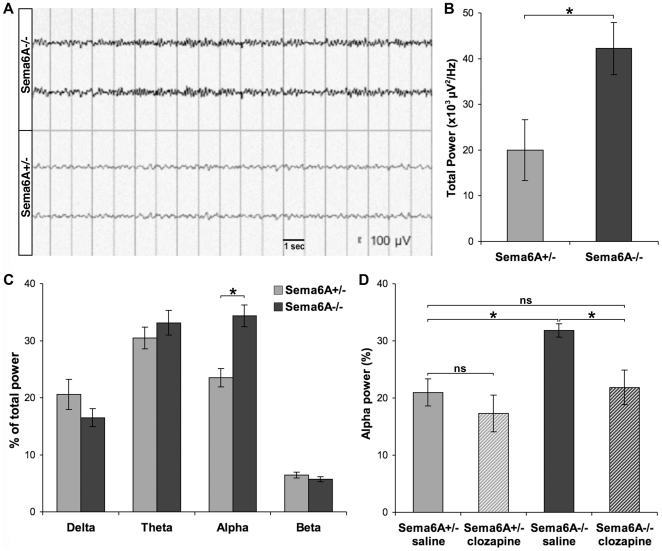
Altered cortical activity patterns.(A) Representative bilateral cortical EEG traces from Sema6A−/− and Sema6A+/− animals in spontaneous, freely moving conditions. (B) Quantification of total spectral power in Sema6A+/− (n = 3) and Sema6A−/− (n = 4) animals, p<0.005. (C) Quantification of relative power of spectral bands in Sema6A+/− (n = 7) and Sema6A−/− (n = 8); a significant increase in the alpha band was observed p<0.001. (D) Increase in relative power in the alpha band in Sema6A−/− is reversed by administration of clozapine, p<0.05. No significant effect of clozapine on alpha power in Sema6A+/− animals was observed (n = 4 for all groups). Clozapine at this dose did not affect the other spectral power bands in either genotype (not shown). *p<0.05; ns: non-significant. Error bars represent ± SEM.